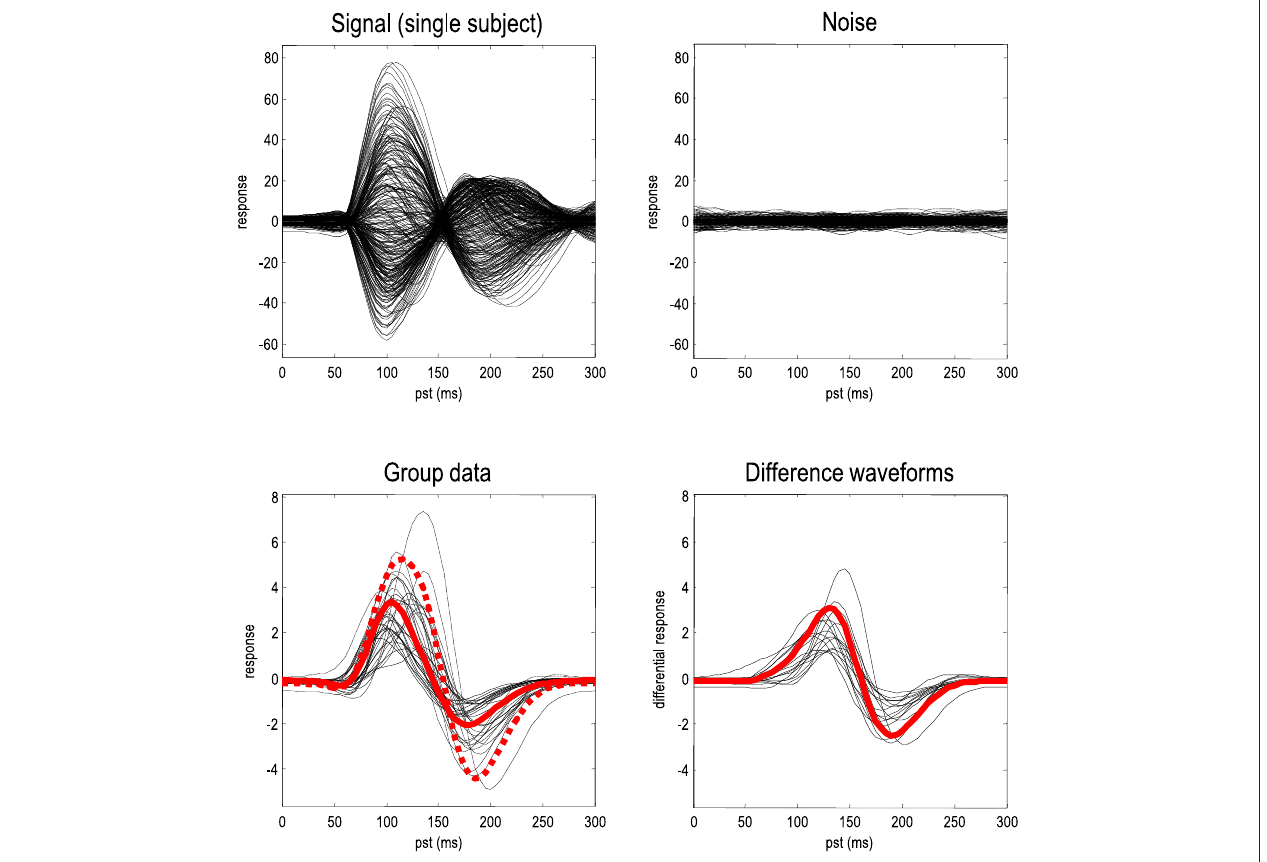
FIGURE 2 | Simulated data. The upper panel shows channel data from a single subject as a function of peristimulus time. The solid lines (upper left) correspond to the simulated signal, while the dotted lines correspond to signal plus noise. For comparison, the observation noise is shown on the upper right. The lower panels show simulated responses over subjects in terms of a mixture of sensor data based upon the first principal component of the prior predictive covariance. The solid lines (middle left) correspond to the first (standard) condition, while the dotted lines report the second (oddball) condition. The right panel shows the condition-specific effects in terms of the waveform differences between the two conditions; namely, the mismatch negativity. The red lines report the grand means of the condition-specific responses (left) and differences